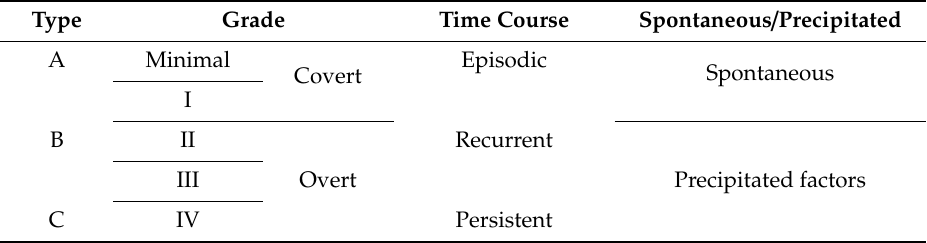
Table 1. Clinical characterization of HE (adapted from AASLD / EASL guidelines